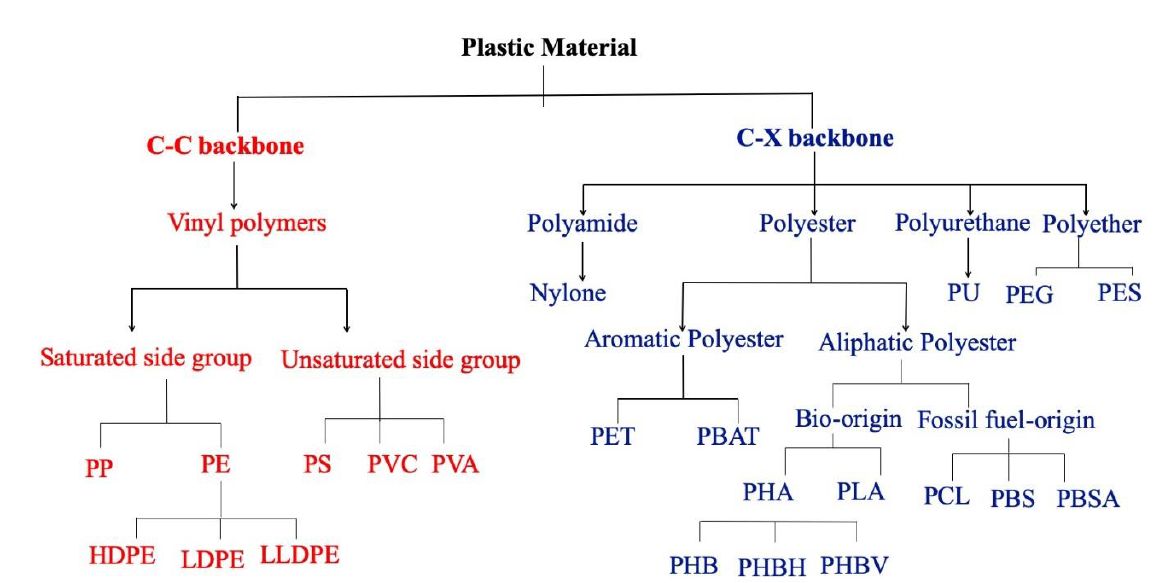
Figure 1. The hierarchical classification of plastic types based on atomic composition of the main backbone.